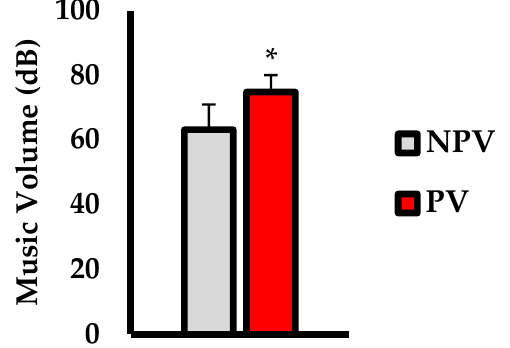
Figure 1. Average music volume chosen in decibels (dB) between non-preferred volume (NPV) and preferred volume (PV) conditions. Data are presented as mean ± SD. * indicates significantly different than NPV ( p < 0.05).